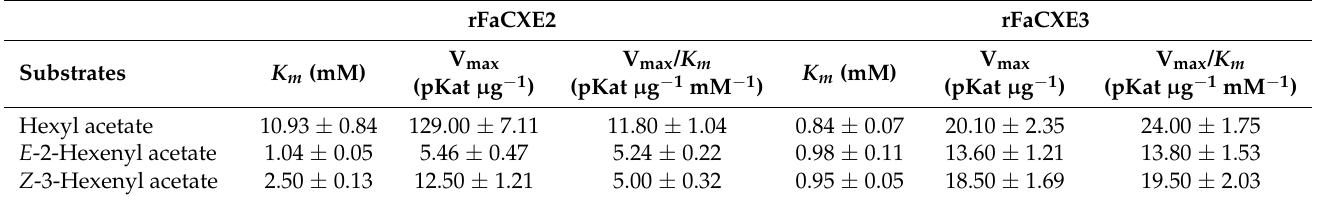
Table 2. Enzymatic kinetic analysis of FaCXEs recombinant proteins.